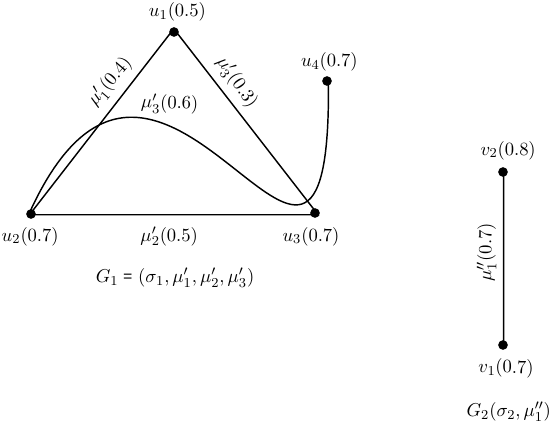
Figure 11: Two fuzzy graph structures Figure 11. Two fuzzy-graph